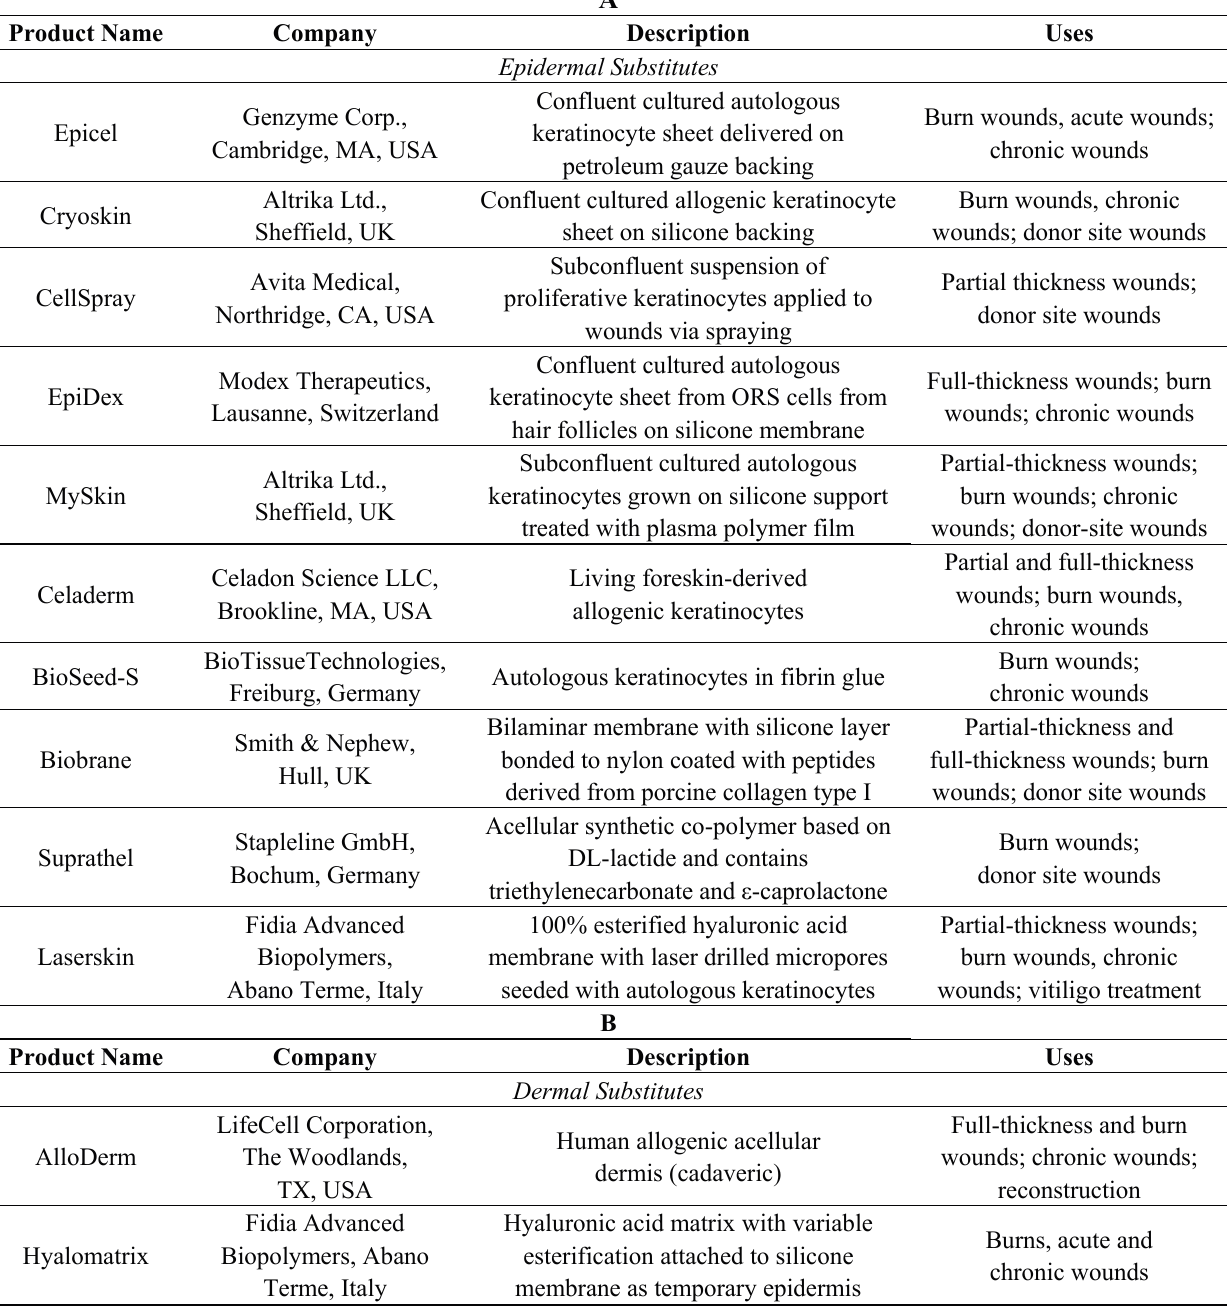
Table 2. Some examples of skin scaffolds: epidermal substitutes ( A ); dermal substitutes ( B ); composite substitutes ( C )